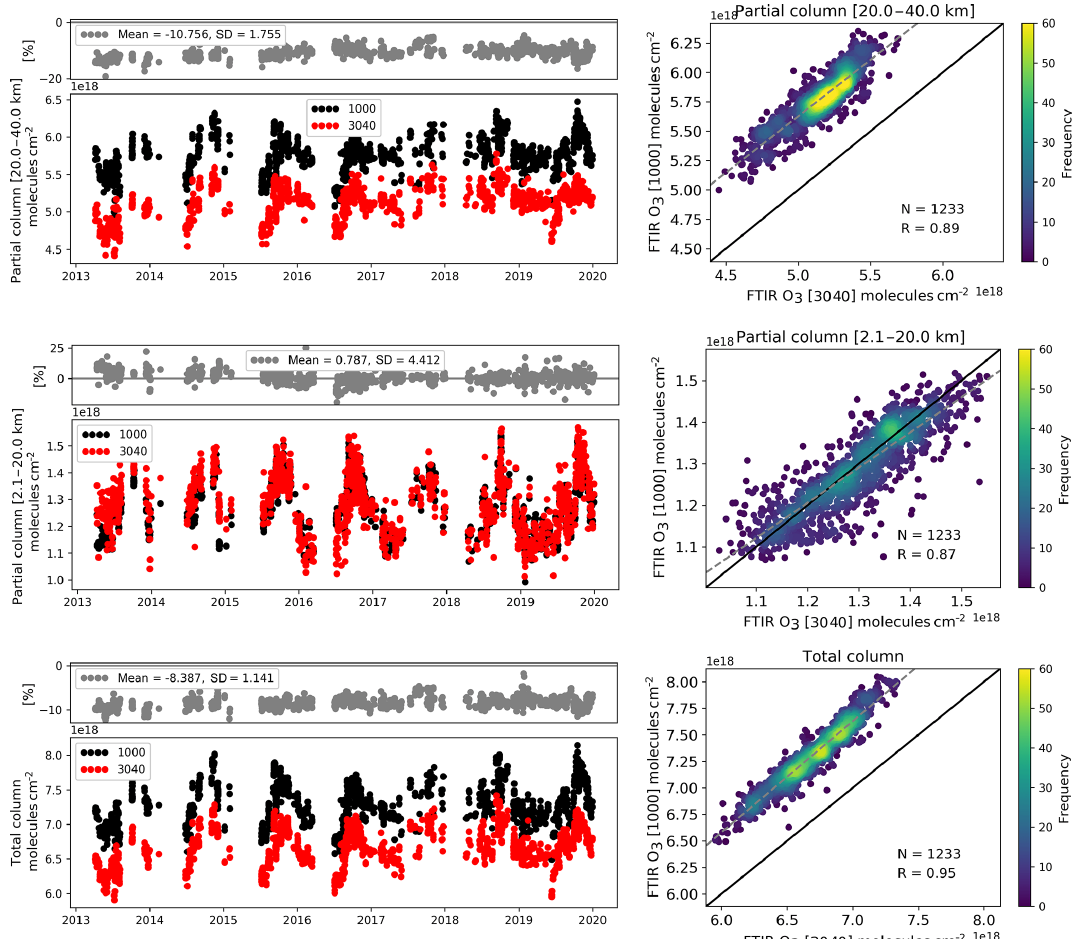
Figure 7. The time series of the co-located hourly means of total columns (bottom), partial columns between surface and 20km (middle), and partial columns between 20 and 40km (top) from FTIR retrievals using the 3040cm − 1 (red) and the 1000cm − 1 (black) spectral ranges, together with their relative differences ( ( FTIR_3040 − FTIR_1000 )/ FTIR_1000 × 100%) and their correlations, in which color intensity corresponds to data frequency, at Maïdo between 2013 and 2019. The dashed gray line is the linear regression line. N is the co-located number of data pairs and R is the correlation